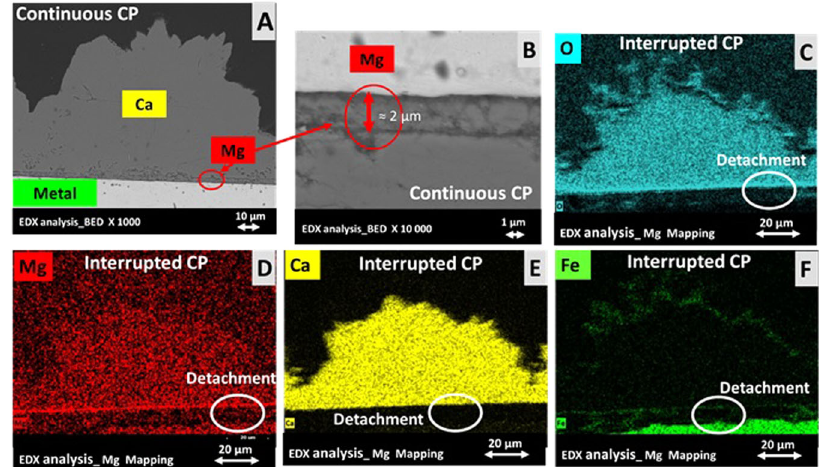
Fig. 6 SEM pictures of the seawater/metal interface state during continuous or interrupted cathodic protection. In ( A , B ), cross-sections of the sample obtain after continuous cathodic protection for 7 days in natural aeration, at 20 °C in static conditions. In ( C – F ), cross-sections pictures of a sample obtain after two interruptions of the cathodic protection, in natural aeration, at 20 °C, under static conditions. EDX mapping of the elements is